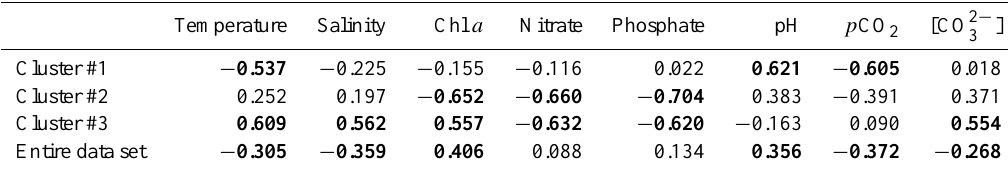
Table 2. Coefficients of correlation between the mass of E. huxleyi and the environmental parameters for the three clusters and the entire data set. The values in bold are significant ( p < 0 . 0001).